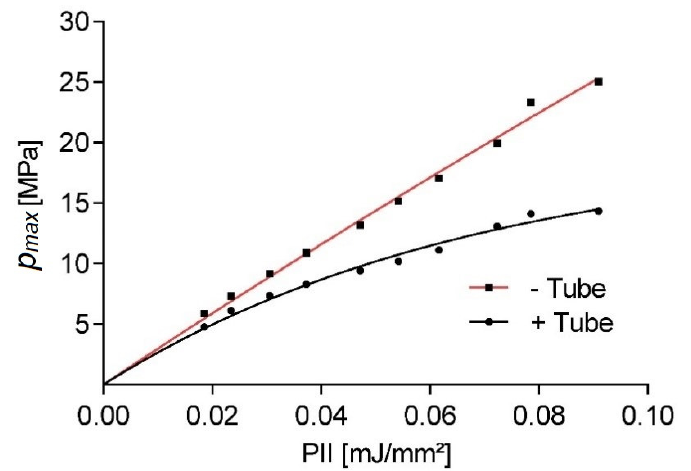
Figure 7. Comparison of measured peak pulse pressure inside a water-filled Falcon tube (black) and a free-field measurement (red) vs. the nominal energy setting of an electromagnet applicator.